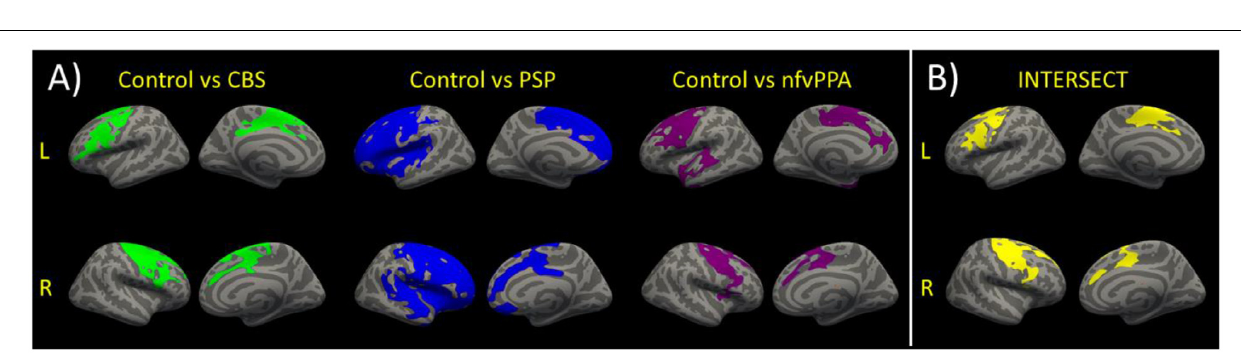
illustrate the region of commonality using the ‘labels_intersect’ command in FreeSurfer ( Figure 3B ). Overlapping regions of cortical thinning in the three patient groups